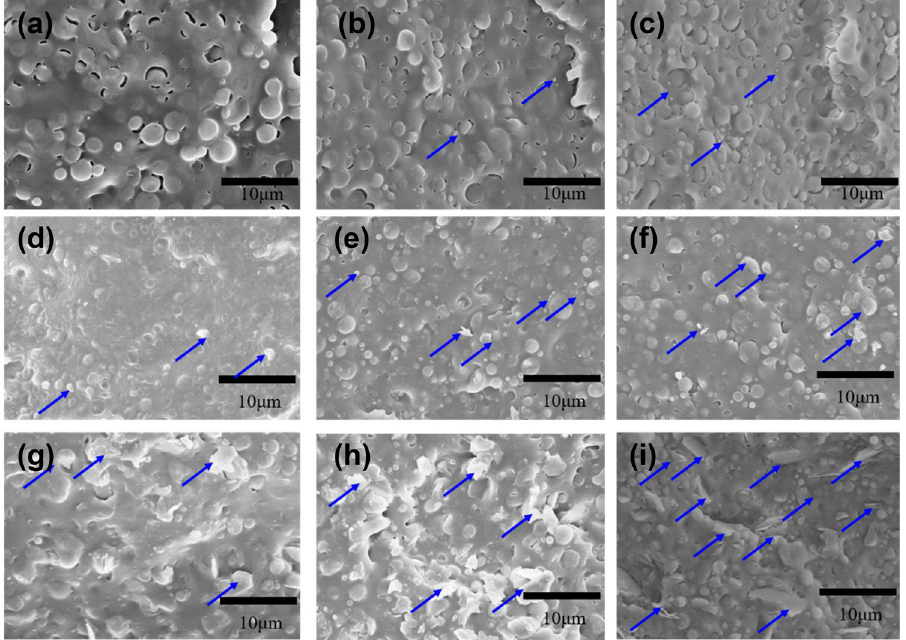
Figure 1: SEM micrographs of blends containing di ff erent amounts of particles: ( a ) PLA/PBAT 70/30, ( b ) diatomite - 1%, ( c ) talc - 1%, ( d ) diatomite - 3%, ( e ) diatomite - 5%, ( f ) diatomite - 7%, ( g ) talc - 3%, ( h ) talc - 5%, ( i ) talc -